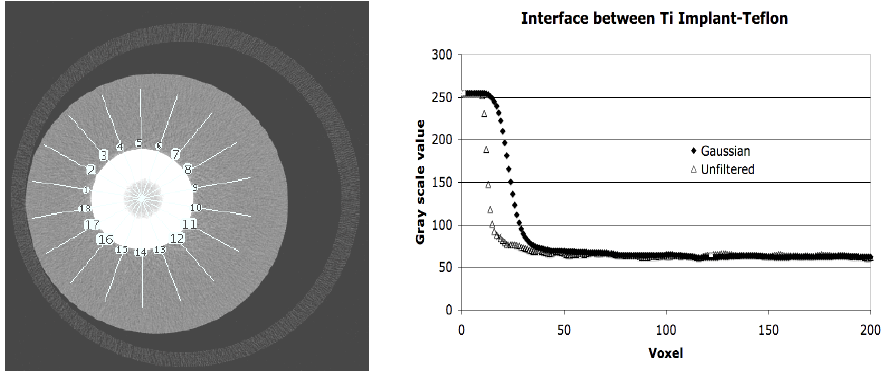
Figure 6. (a) Image of a titanium implant in Teflon with 18 radial traces marked for which gray level profiles were generated. (b) Plots of averaged gray level values of the traces across the titanium-Teflon interface shown in Fig 6a, with and without Gaussian